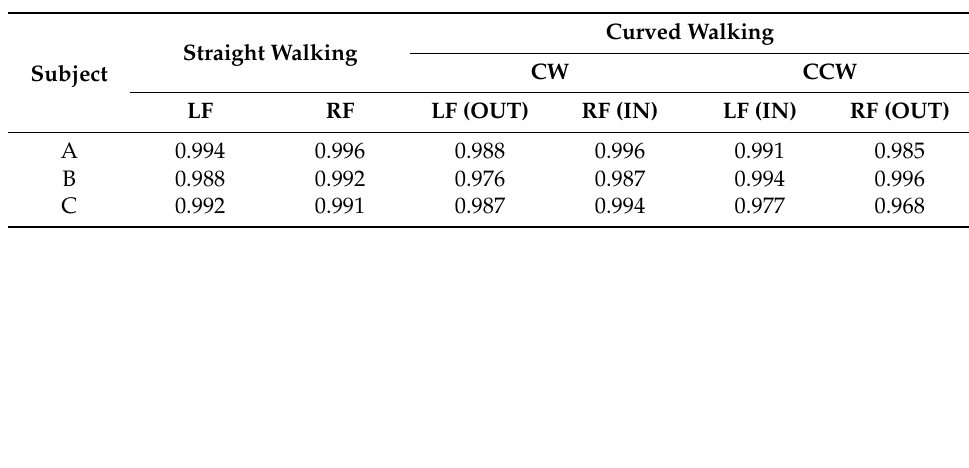
Table 3. Pearson’s correlation coefficient of vertical ground reaction force (vGRF) measured from the Nintendo Wii Balance Board (WBB) and the force